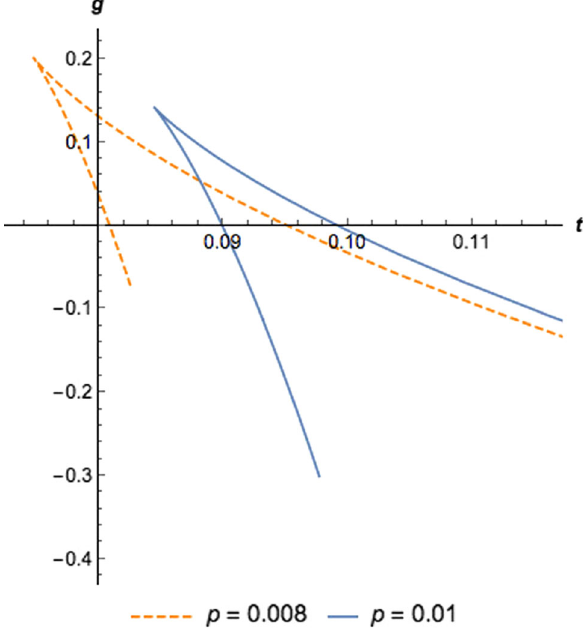
Fig. 7 g − t diagram for the anti-de Sitter case, ω = −